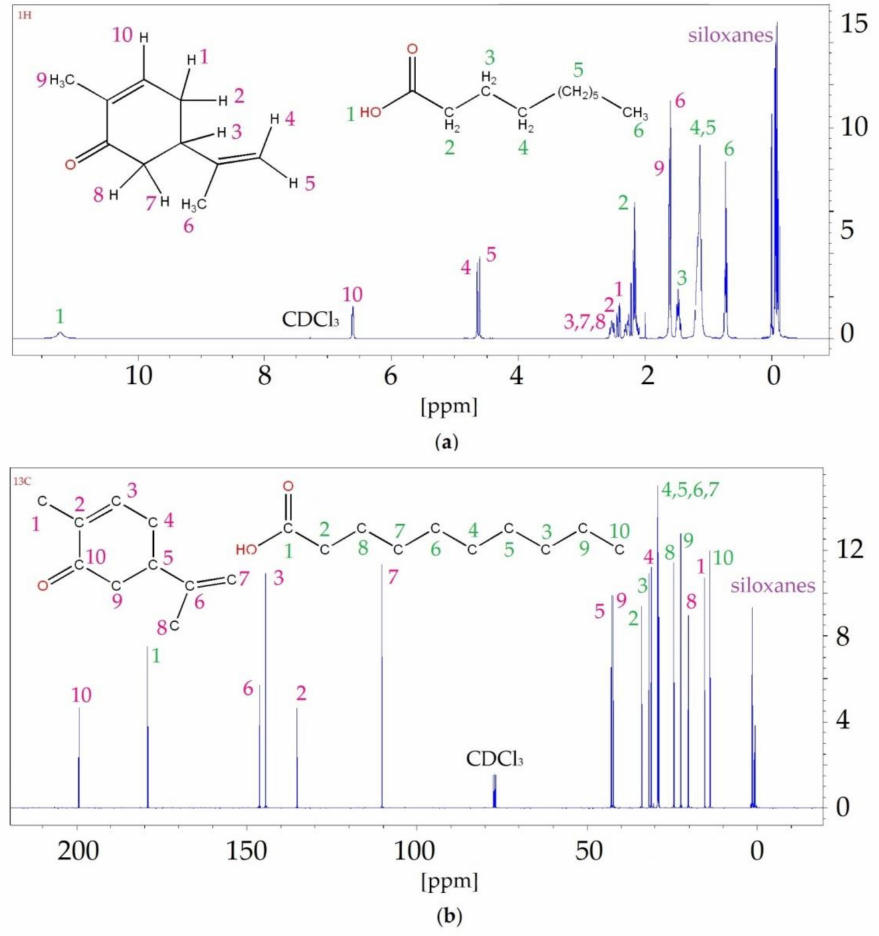
Figure 14. 1 H NMR ( a ) and 13 C NMR ( b ) spectra for C:DA (1:1) after the absorption process of siloxanes from the model biogas stream.